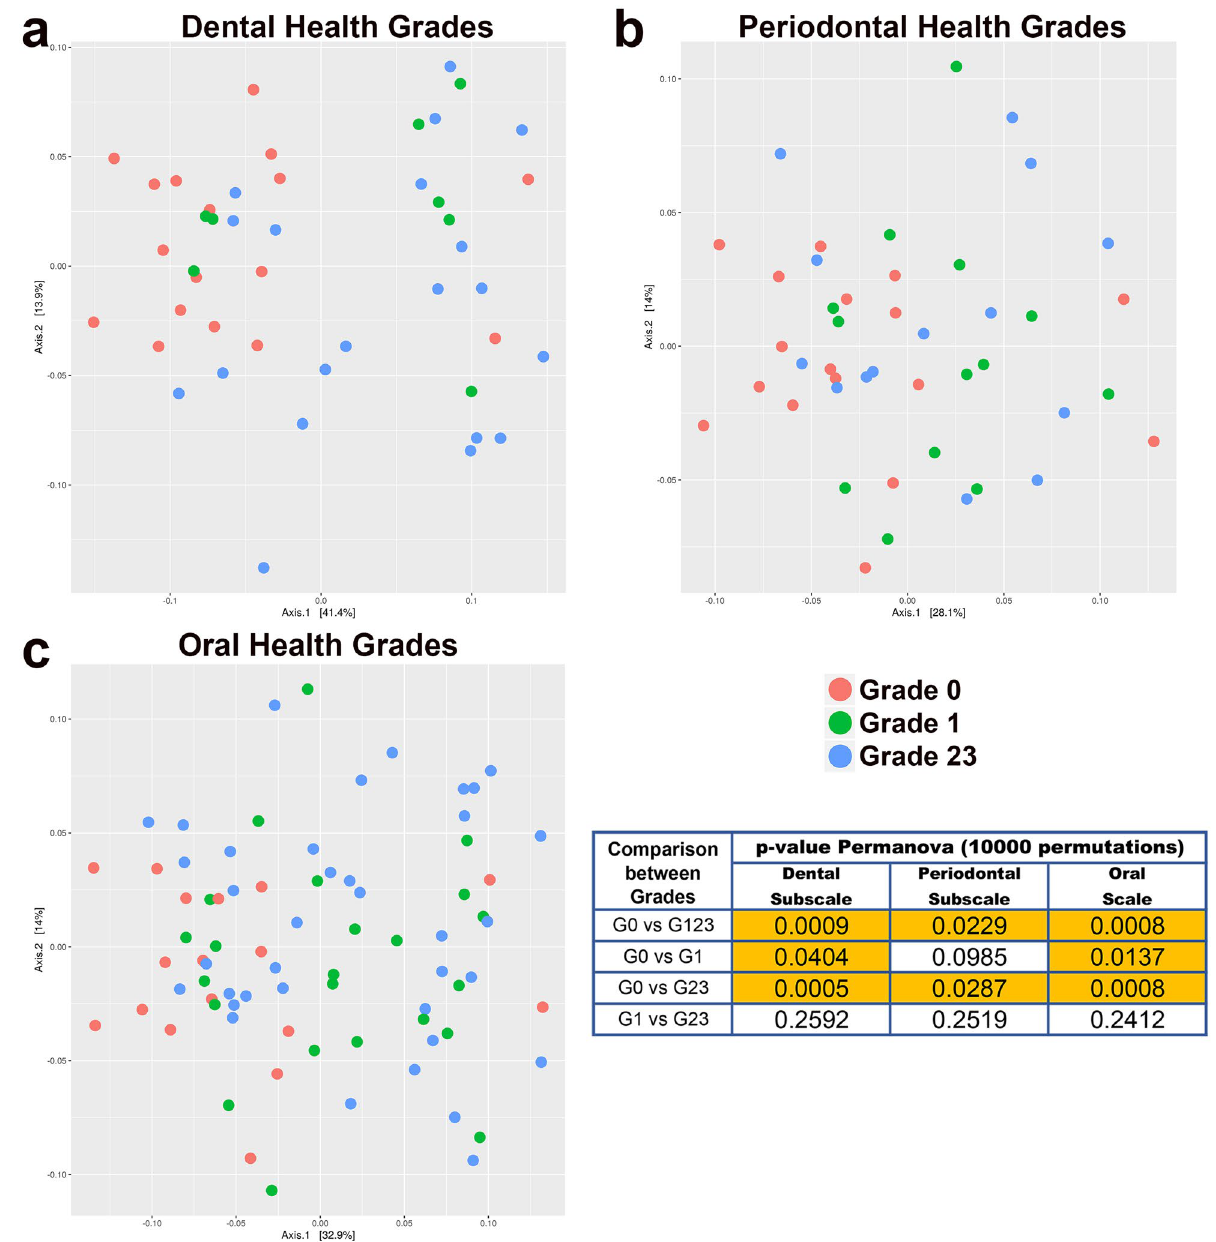
Figure 1. Principal Coordinate Analysis (PCoA), including PERMANOVA test values in the comparison between different grades of dental, periodontal and oral health (graphic made using the phyloseq package, version